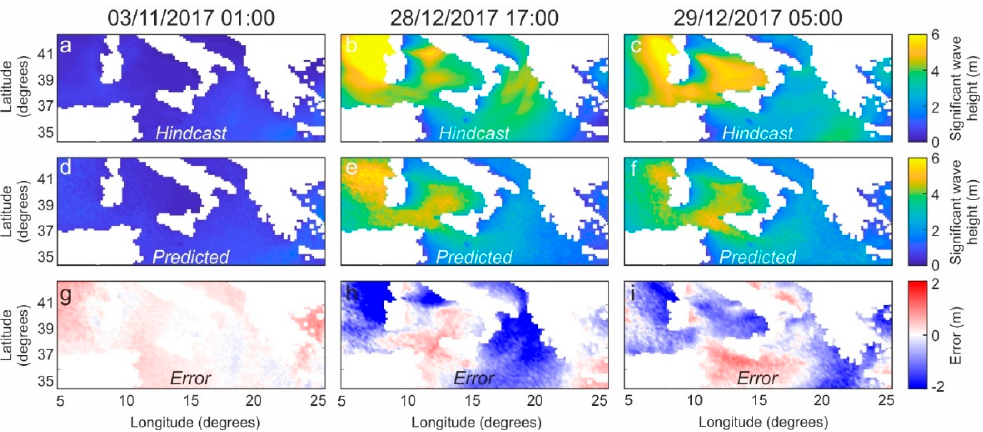
Figure 8. ( a – c ) Hindcast maps of significant sea wave height, ( d – f ) predicted maps of significant